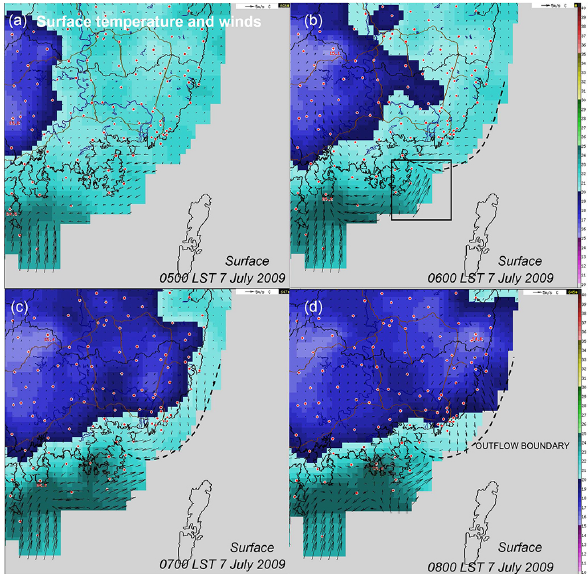
Figure 13. Surface temperature ( ◦ C, colour shading) and wind vec- tors (ms − 1 ) at (a) 05:00, (b) 06:00, (c) 07:00, and (d) 08:00LST 7 July 2009. The red dots were indicated the surface observation stations. The position of the outflow boundary was denoted by a dashed black